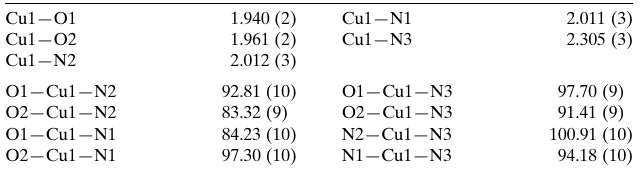
Selected geometric parameters (A˚ , (cid:3) ).